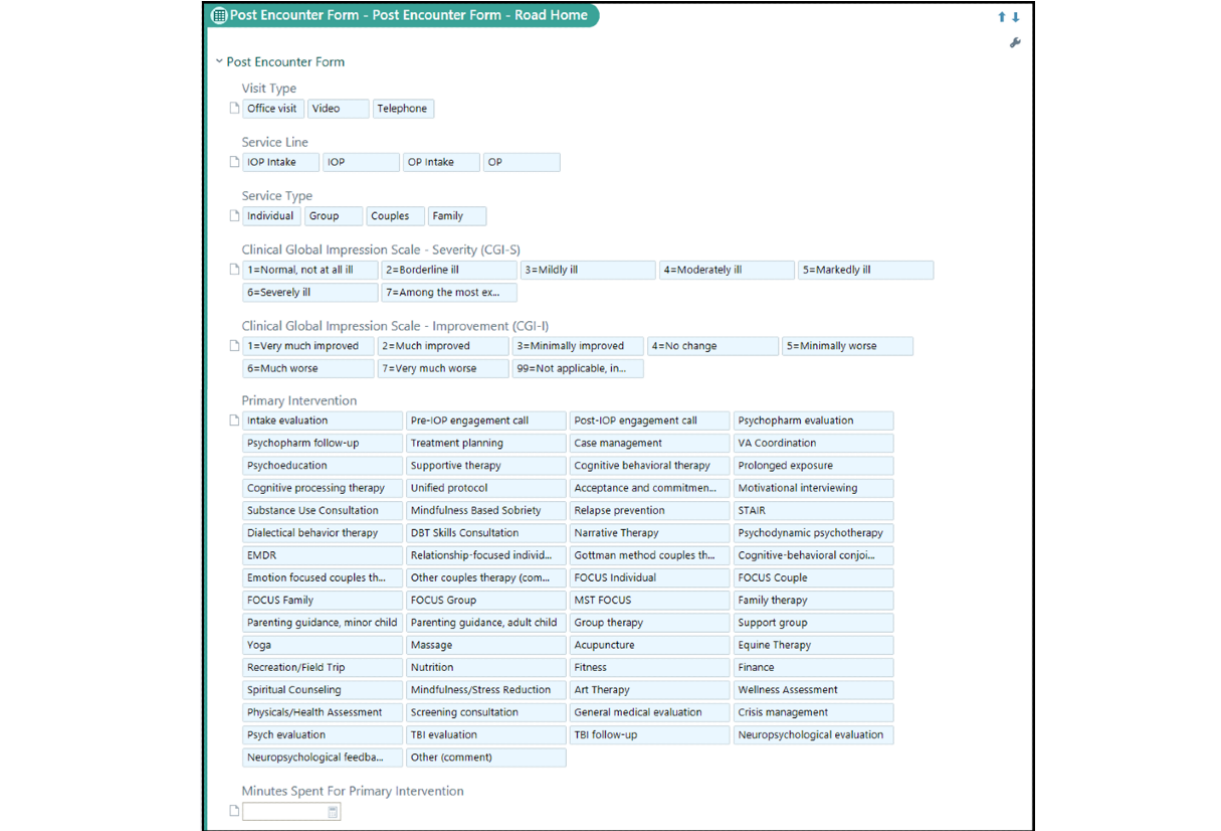
Figure 1. Sample Road Home Program post-encounter form. IOP: intensive out patient; OP: out patient; TBI: traumatic brain injury; VA: Department of Veterans Affairs; STAIR: Skills Training in Affective and Interpersonal Regulation; DBT: dialectical behavior therapy; EMDR: eye-movement desensitization and reprocessing; FOCUS: Families OverComing Under Stress; MST: Military Sexual